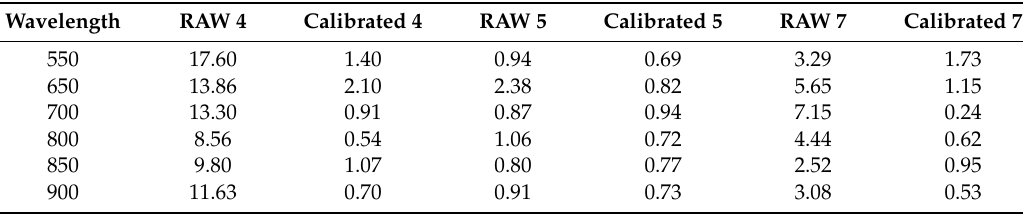
Table 6. The normalized root mean square errors of reflectance values comparing reference spectral curve of verification targets with reflectance values extracted from raw and fully corrected image. The normalization was performed by dividing the RMSE by interquartile range. The values are expressed as